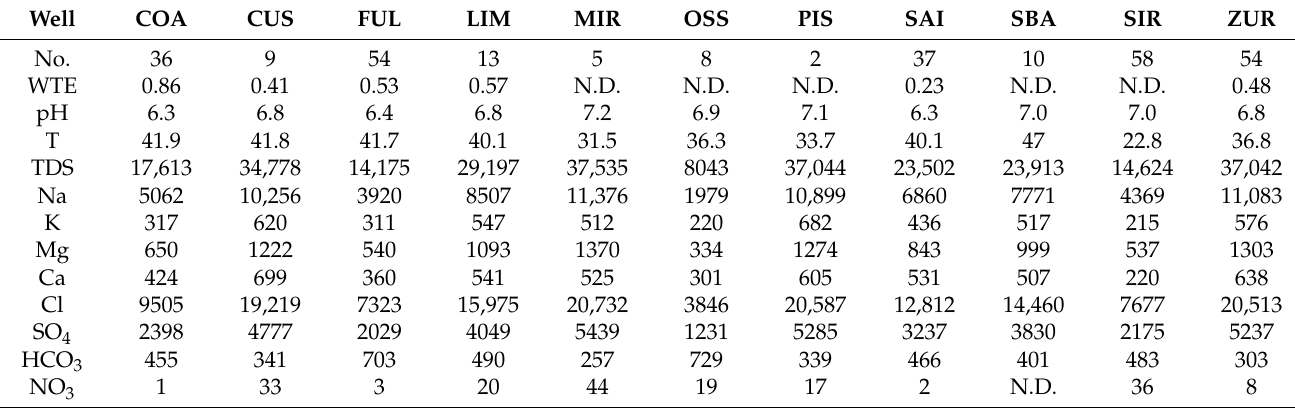
Water table elevations (m a.s.l.) were calculated as the difference between the two abovementioned parameters (Table 2; well locations in Figure 1).